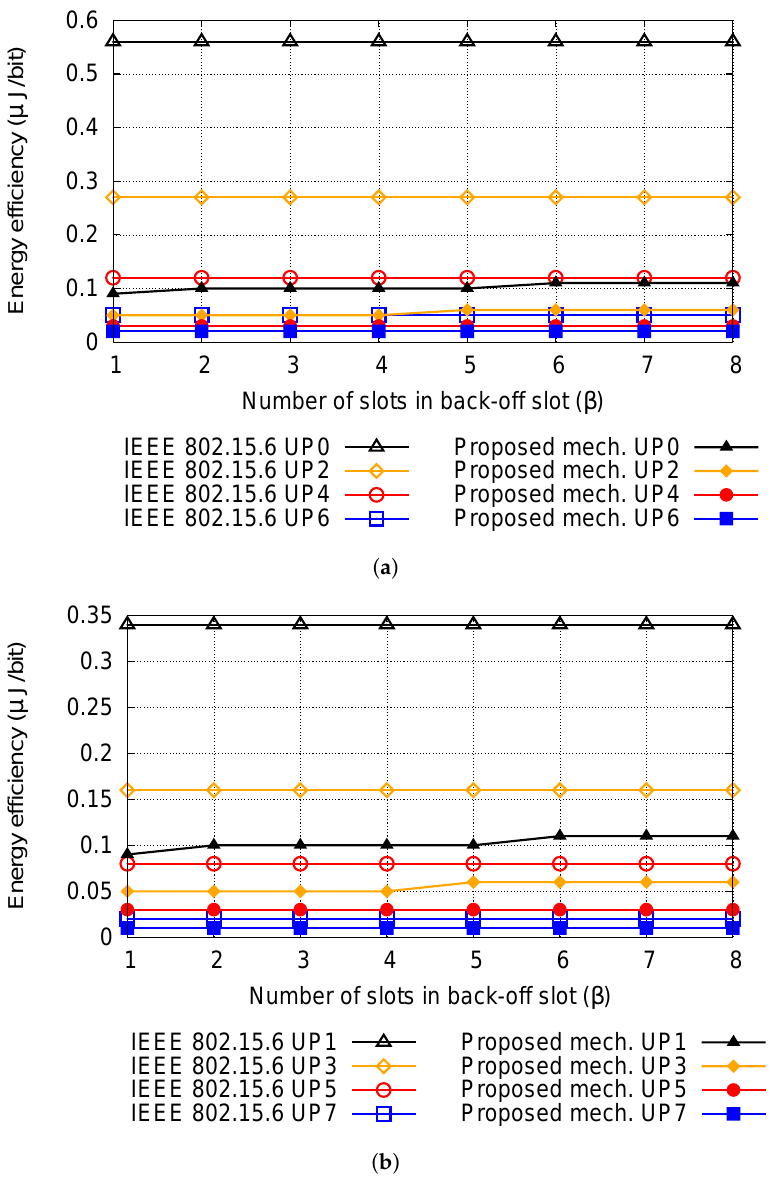
Figure 10. Energy efficiency comparison of IEEE 802.15.6 and proposed mechanism for different UP (Scenario 3). ( a ) Energy efficiency comparison for UP 0, 2, 4, and 6; ( b ) energy efficiency comparison for UP 1, 3, 5, and